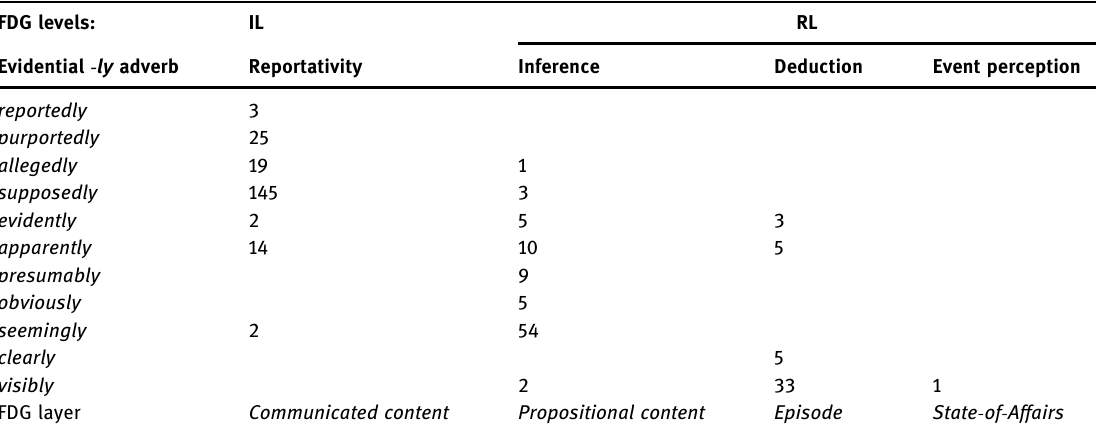
Table 2: FDG classi fi cation of evidential - ly adverbs in noun phrases FDG levels: